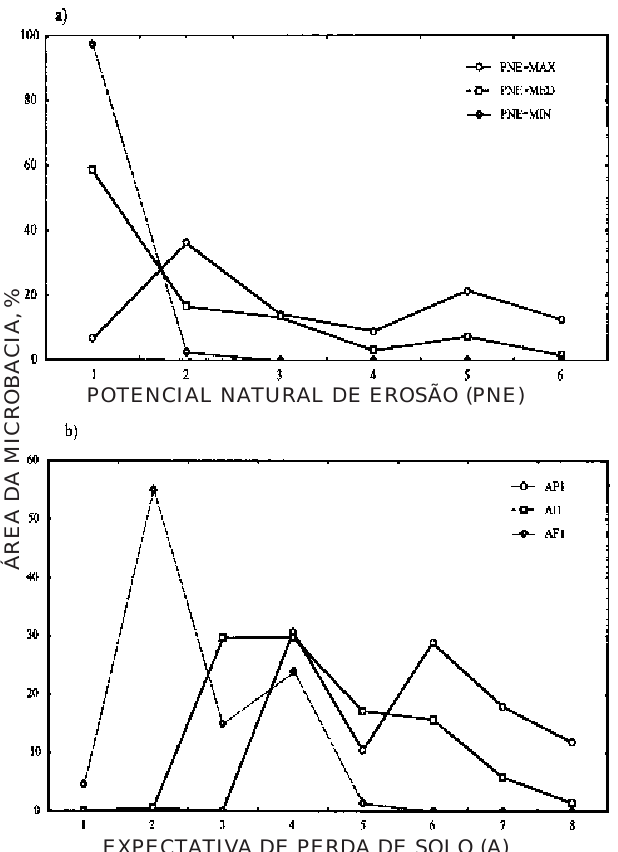
Figura 1. Distribuição relativa das classes de PNE segundo variação dos valores de erosividade (R) expressos de acordo com percentual sobre área da microbacia.